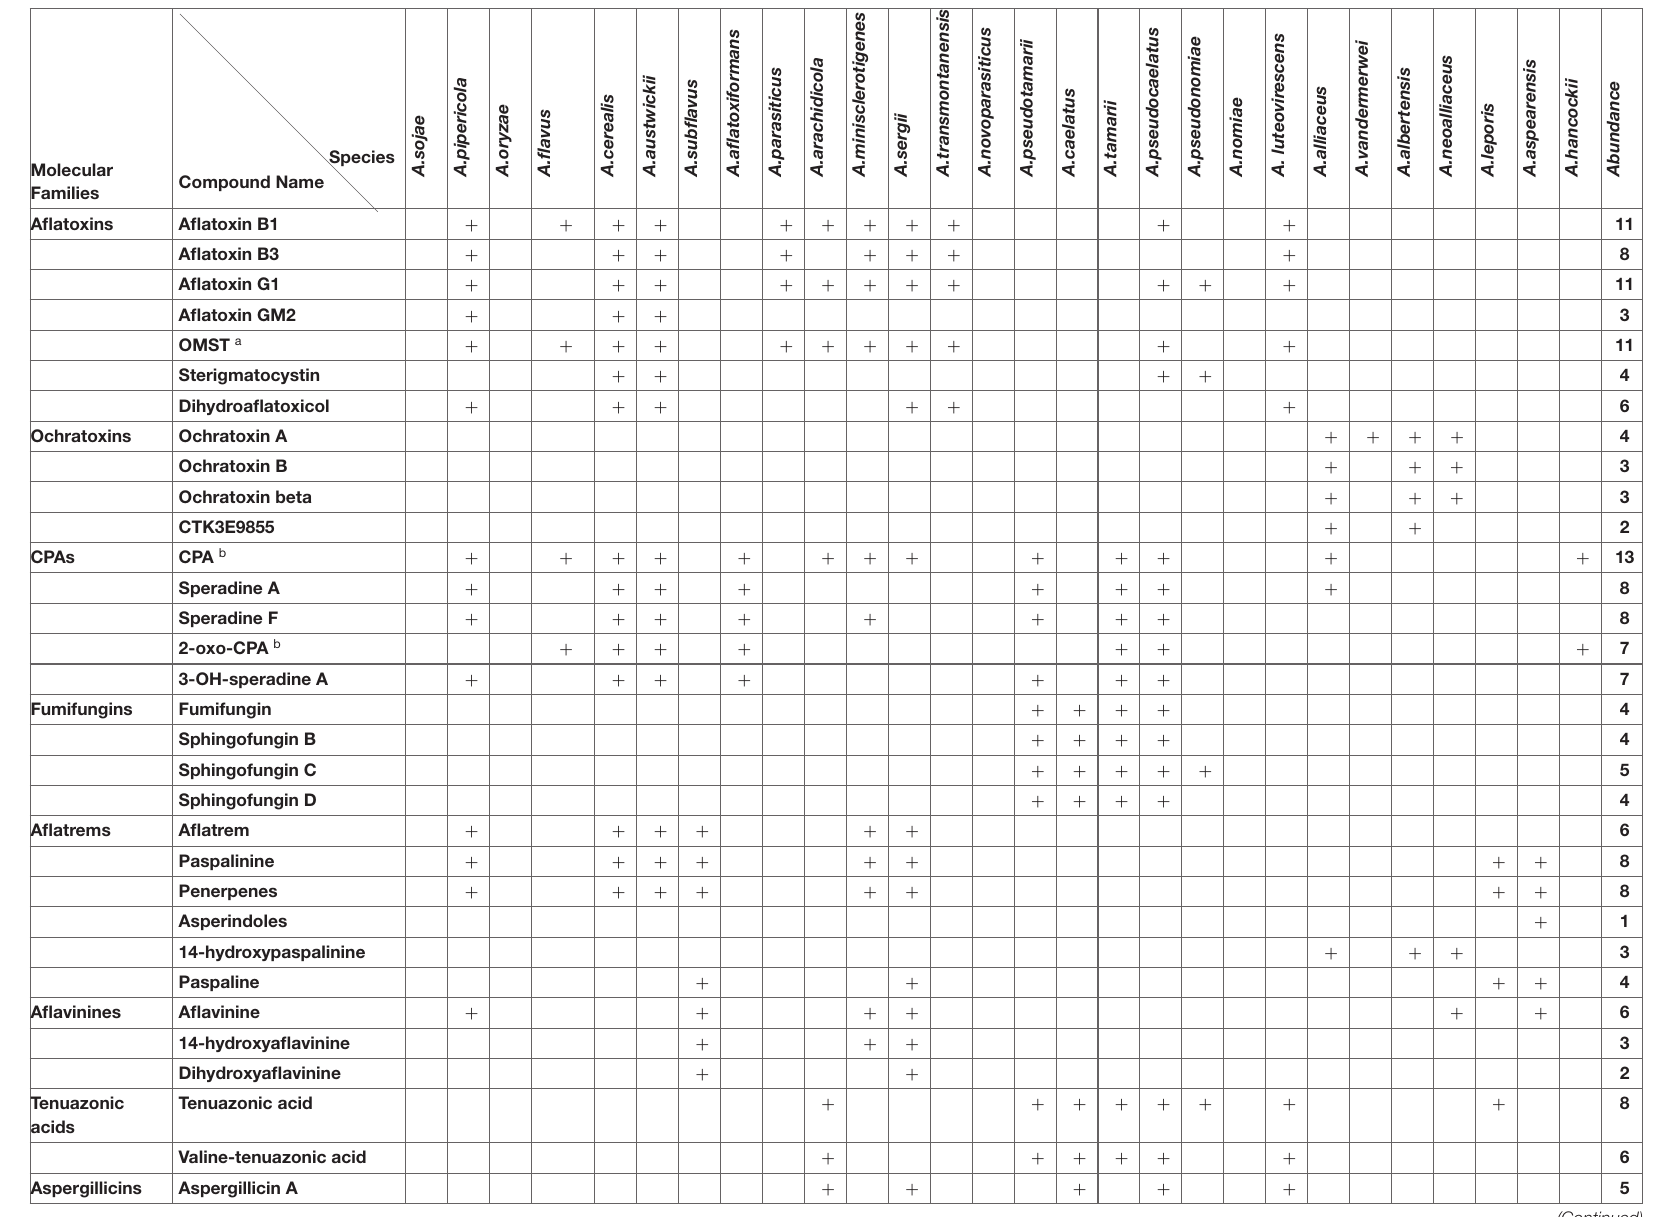
TABLE 1 | Overview of fungal secondary metabolites detected in this study and their producing species in Aspergillus section Flavi .